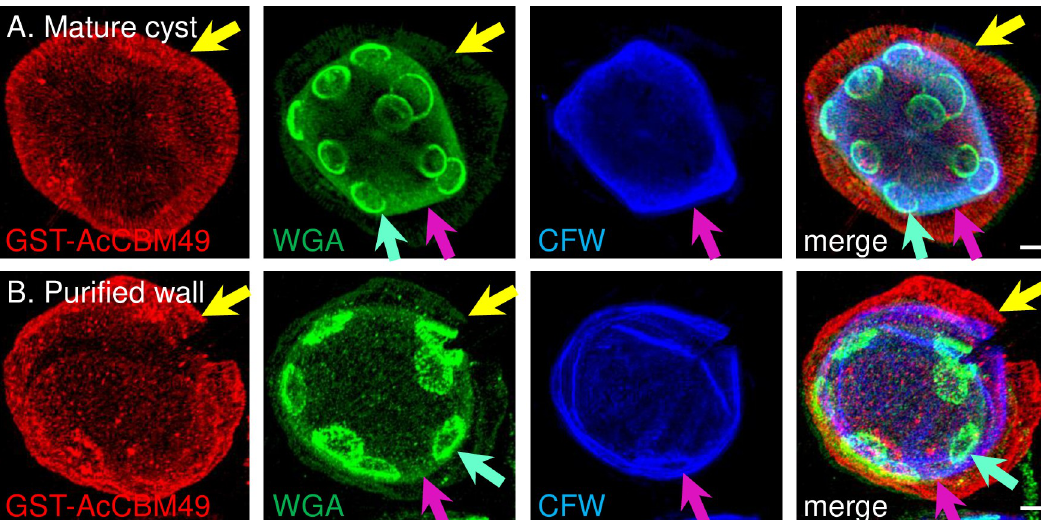
Fig 2. SIM showed purified A . castellanii cyst walls retained distinct ectocyst layer and endocyst layer, as well as ostioles. The ectocyst layer (yellow arrows) of a mature cyst (A) and purified cyst wall (B) labeled red with GST-AcCBM49; the edges of ostioles (turquoise arrows) labeled green with WGA; and the endocyst layer (pink arrows) labeled blue with CFW. WGA also labeled less strongly the endocyst and ectocyst layers. While it appears that some ostioles overlap each other, rotation of the deconvolved images showed they are actually on opposite sides of the spherical surface. Scale bars are 2 μ